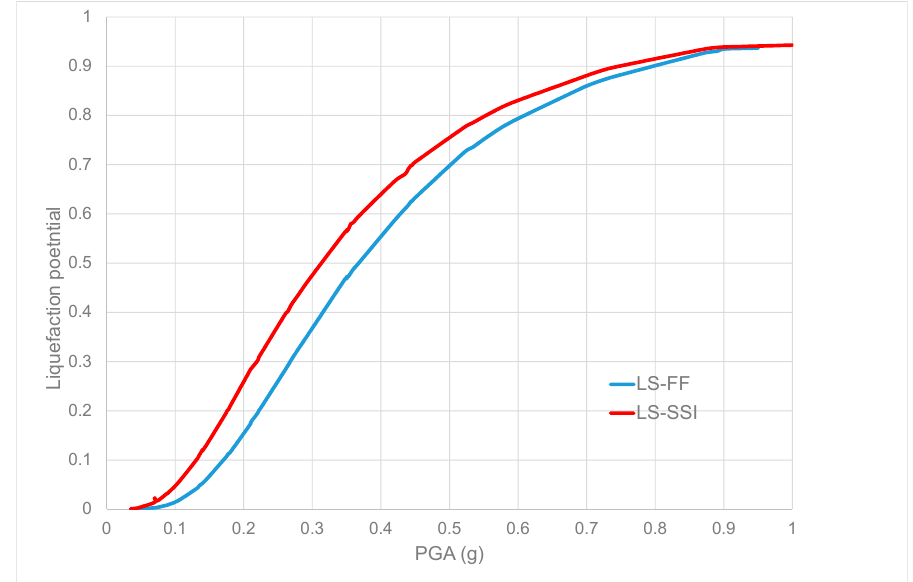
Figure 13. SSI: liquefaction potential (LP): lateral spread (LS) and settlement (ST) comparison.